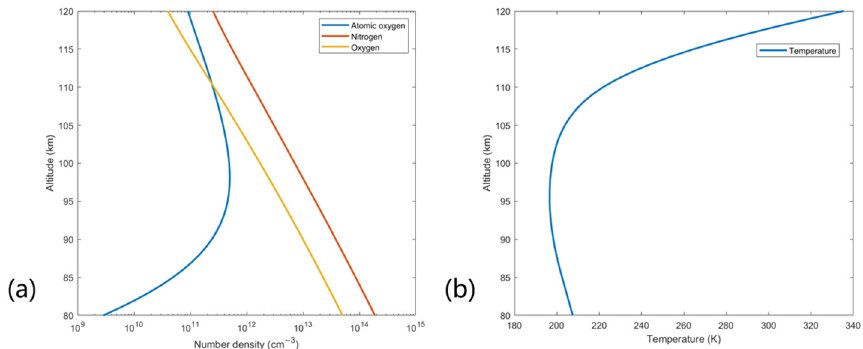
Figure 4. Simulation configurations for the simulated observed spectra. Subgraph ( a ) corresponds to the number density of oxygen, atomic oxygen, nitrogen, and ( b ) corresponds to the temperature, respectively.